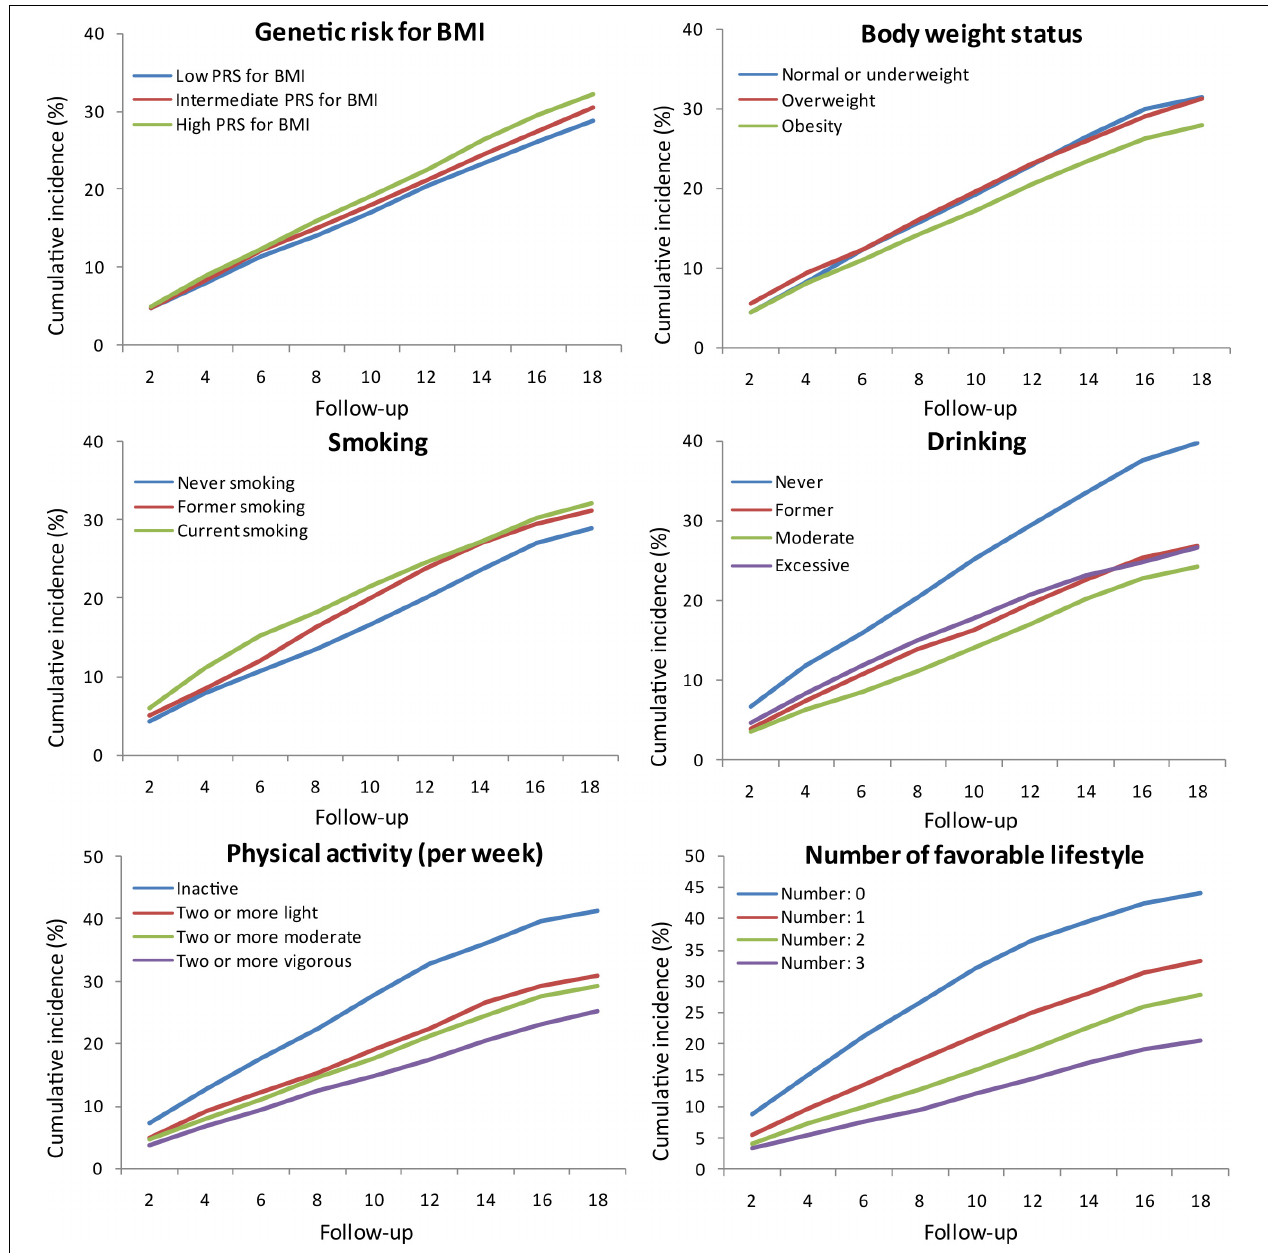
FIGURE 1 | Cumulative incidence of cognitive impairment according to PRS for BMI, body weight status, and lifestyle. PRS, polygenic risk score; BMI, body mass